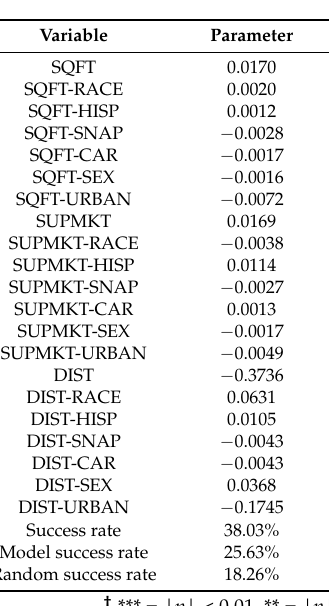
Table 2. Conditional logit model